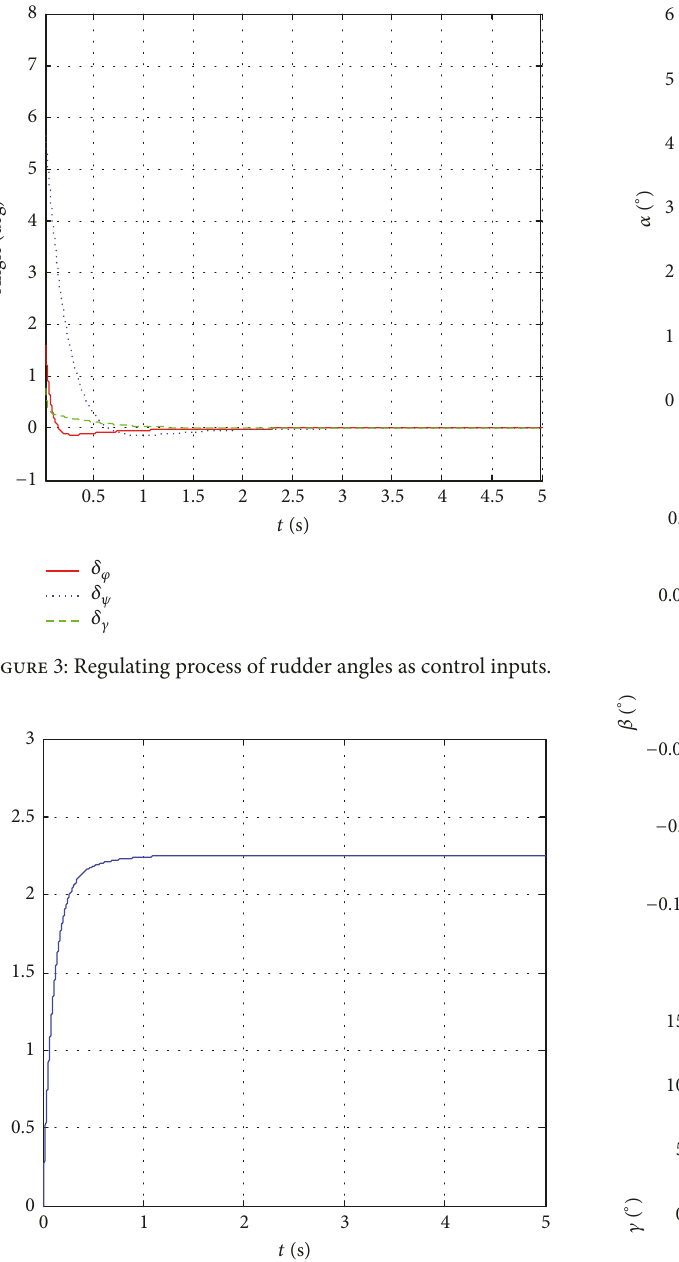
Figure 4: Performance index regulating process.